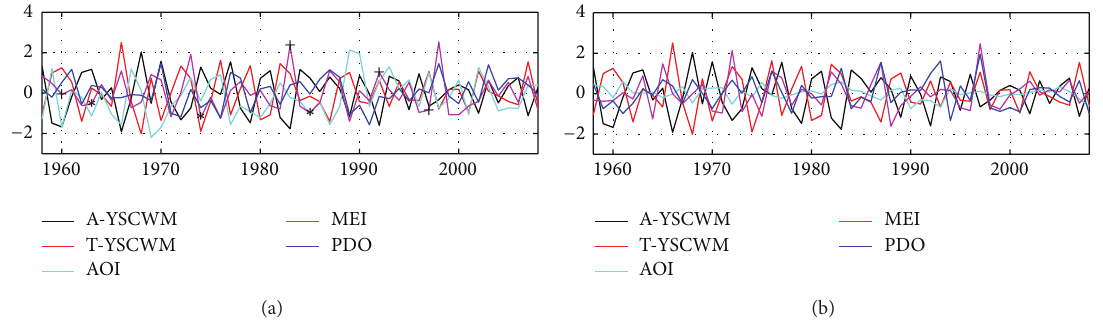
Figure 4: Interannual time series of (a) winter AO, MEI, and PDO indices, and A-YSCWM and T-YSCWM in August (b) summer AO, ENSO, PDO, and the A-YSCWM and T-YSCWM in August. Time series of the A-YSCWM and T-YSCWM are standardized. The A-YSCWM and T-YSCWM represent the area and averaged temperature of the YSCWM, respectively. The “+” represents the El Ni˜no events, and the “ ∗ ” represents the La Ni˜na